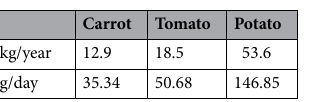
Table 10. Consumption of individual vegetables in Slovakia 66 .